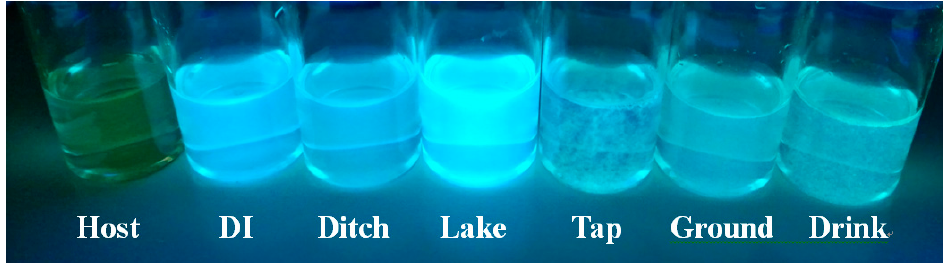
Figure 5. Color changes by UV light for probe L (40 µ M) in different sources of water (DMSO : H 2 O = 1 : 9 v/v) containing 5 equiv. of Al 3+ .